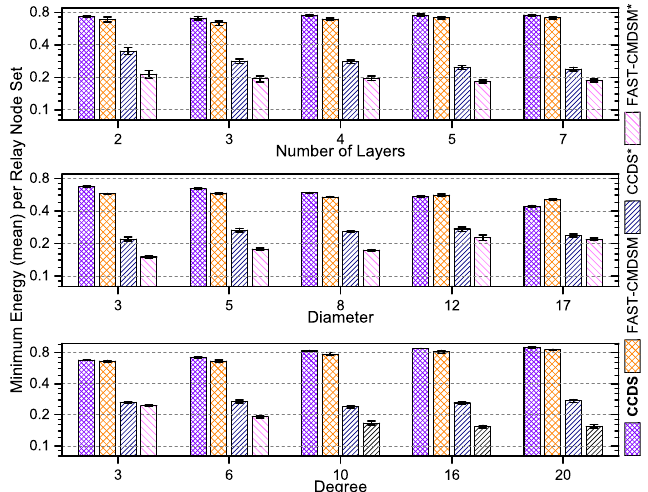
Figure 18. Energy awareness of the competitors (Low skewness).